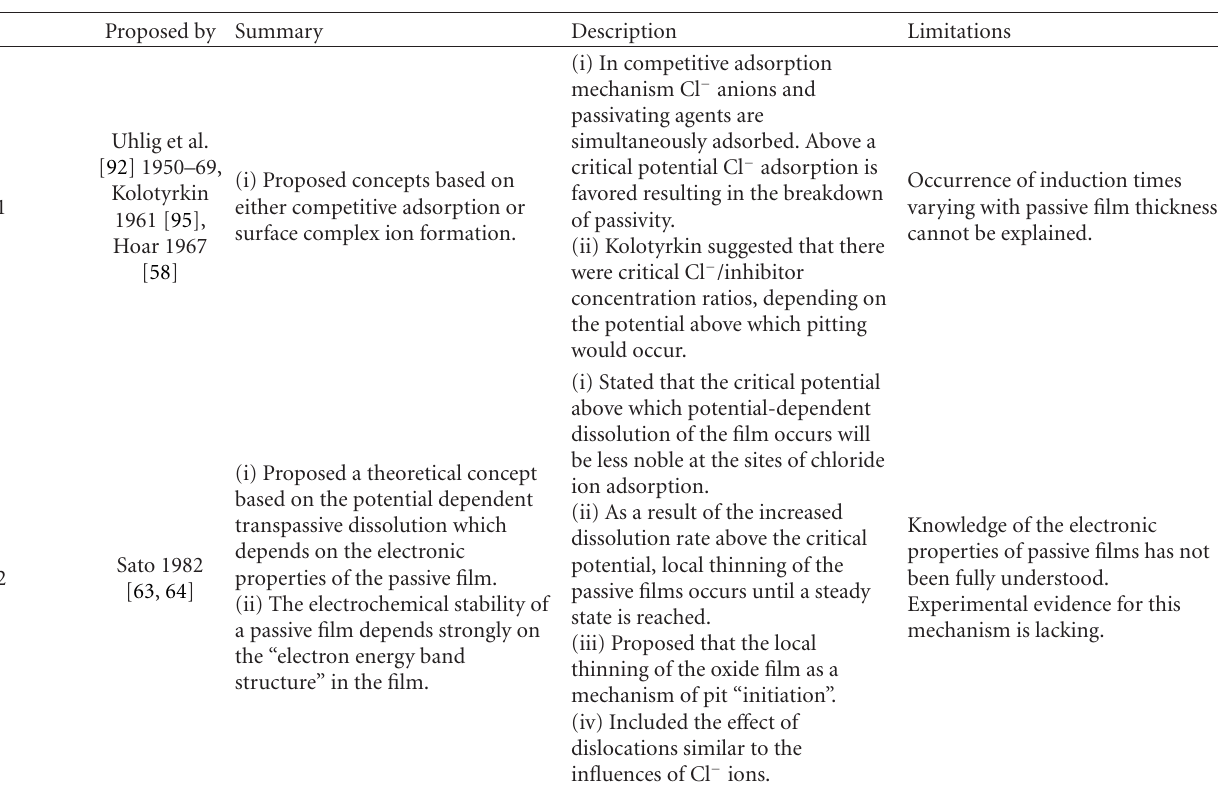
Table 5: Adsorption-induced